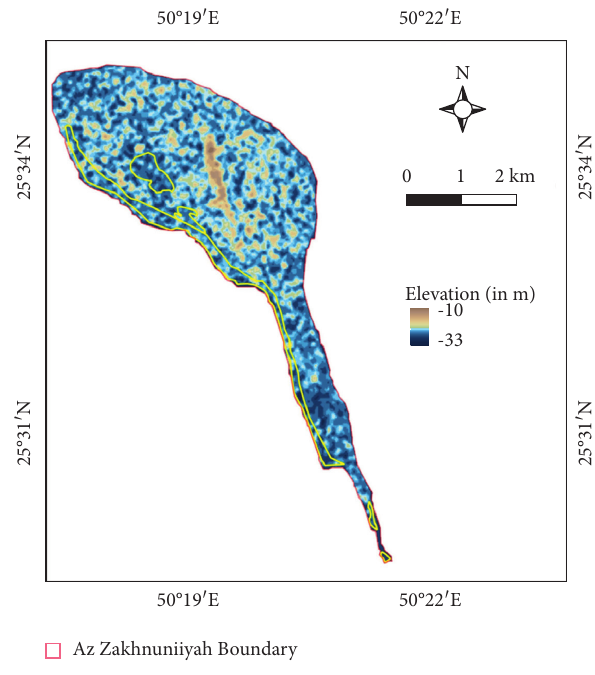
Figure 5: Digital elevation model map showing elevation in m. Note: the fill sink operation was performed on this DEM later to remove many negative values which cause accuracy problems. The raw DEM is shown for better visualization.